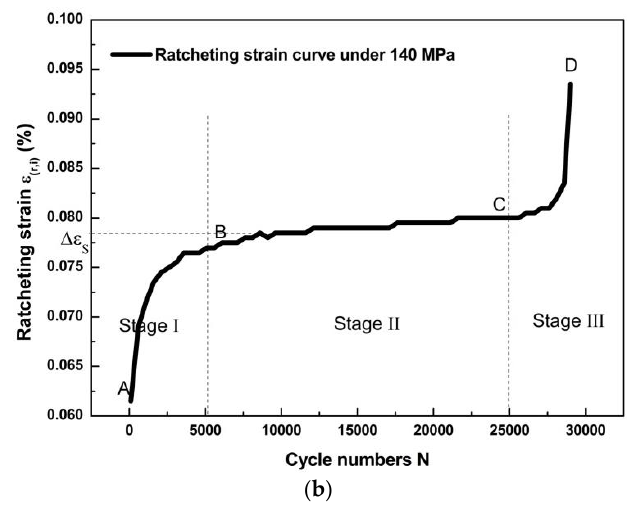
Figure 2. The deformation curves under σ max of 140 MPa in AZ31B magnesium specimen: ( a ) The hysteresis loops under different cycles; ( b ) The ratcheting evolution curve under different cycles.